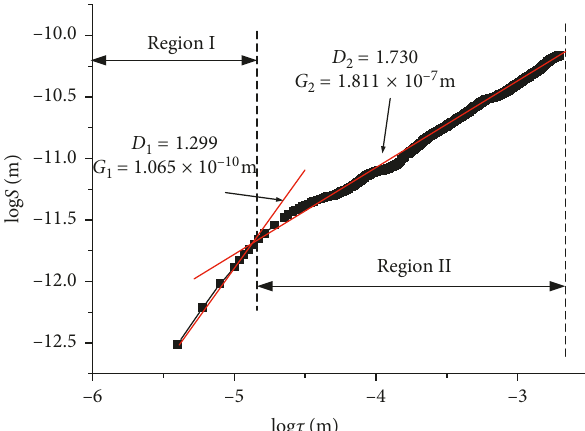
Figure 5: The structural function diagram of the contact interface contour Table 1: The fractal parameter values of the contact interface. D 1 D 2 G 1 (m)